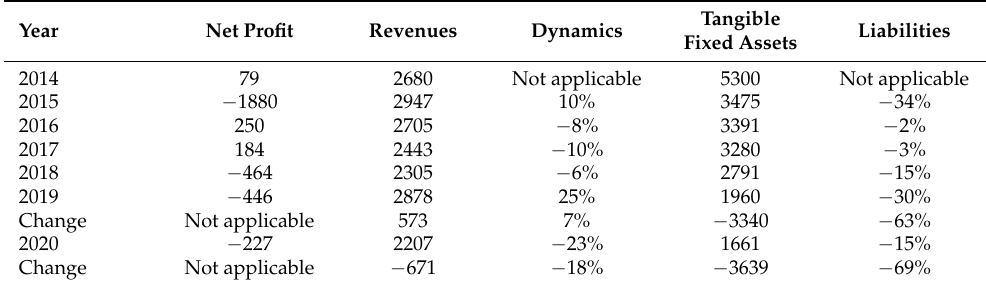
Table 14. Net profit, revenues and property, Tangible fixed assets of ZE PAK Capital Group in